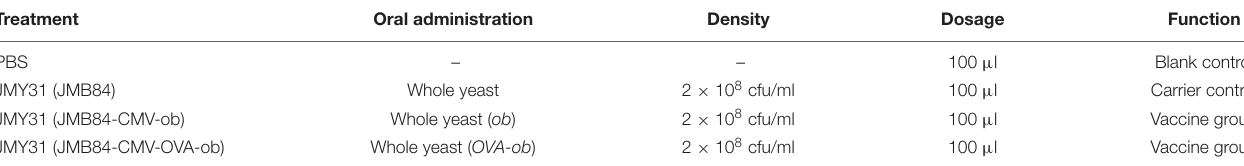
TABLE 1 | Oral administration treatments for each experiment group. Treatment Oral